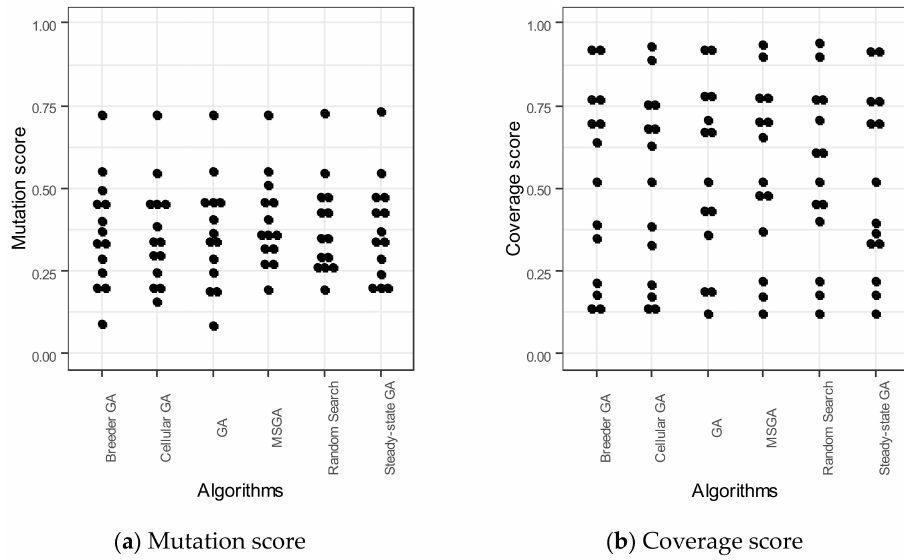
Figure 4. Average scores of mutations and coverages for each algorithm.